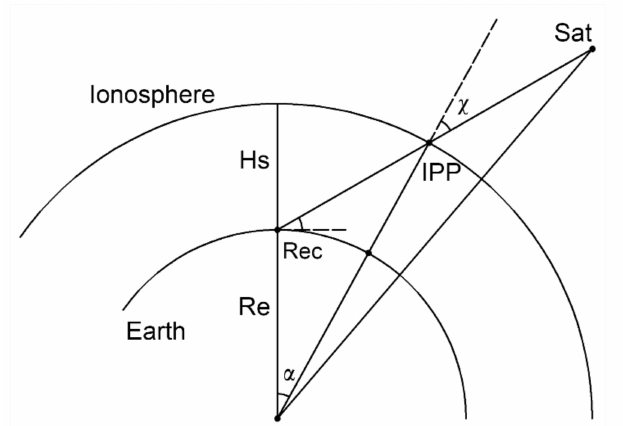
Figure 1. Diagram of ionospheric single layer model. All the ionospheric electrons are assumed to concentrate on an infinite thin single layer. The intersection of the ionospheric single layer and the sightline between the receiver and the satellite is defined as ionospheric piercing point (IPP). Hs stands for the height of the ionospheric single layer.